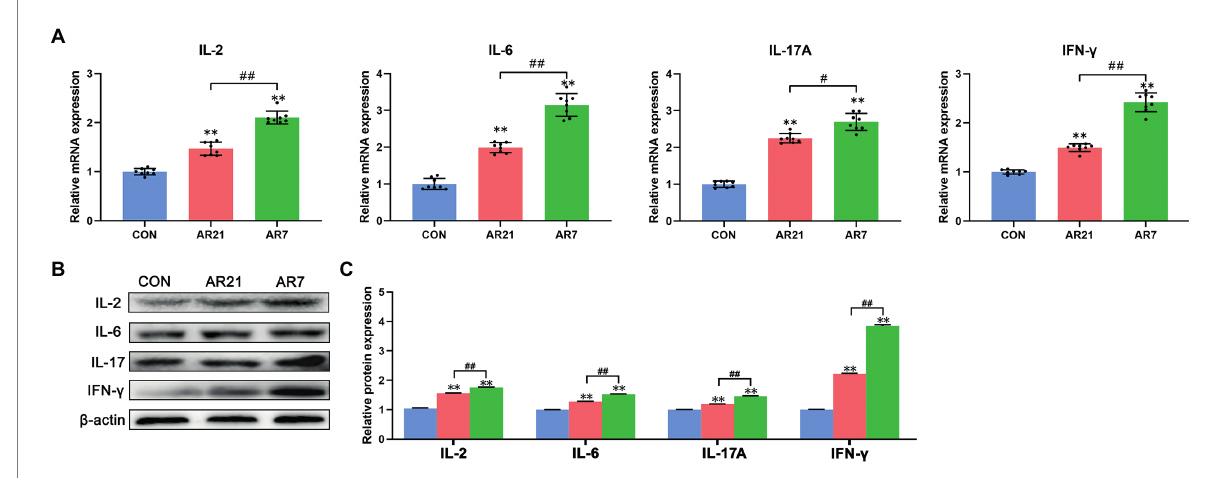
FIGURE 8 Effects of artificial rearing on cytokines in piglet colon. (A) Relative mRNA expression of IL-2, IL-6, IL-17A, and IFN- γ . (B,C) Relative protein expression of IL-2, IL-6, IL-17A, and IFN- γ . Data are presented with mean ± SD. ** p < 0.01 versus the CON group; ## p < 0.01 versus the AR21 group. n = 8 piglets.